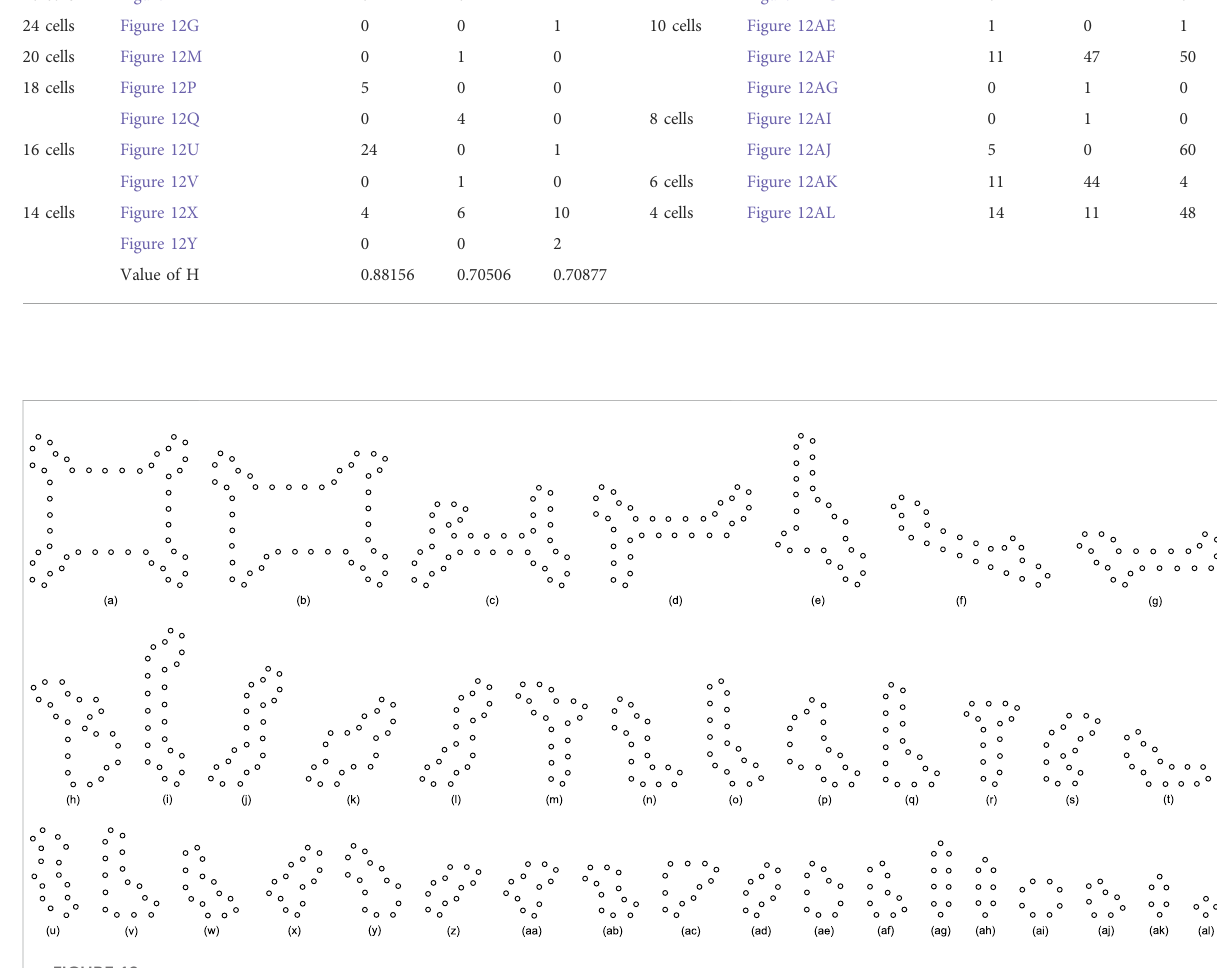
FIGURE 12 All fi nal loop structures starting from the con fi guration in Figure 7E by the greedy selection, adding, and changing